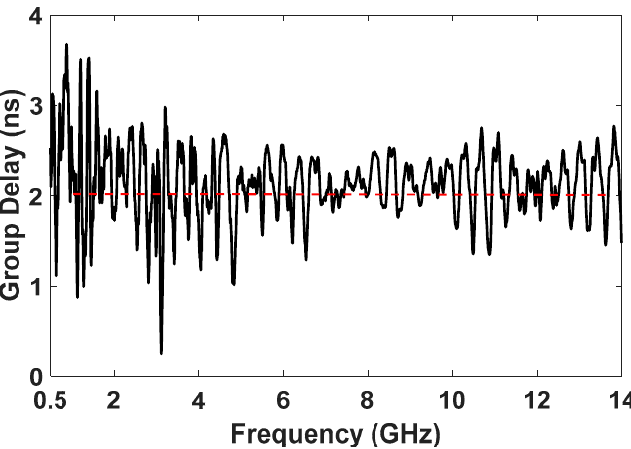
Figure 13. Measured group delay of the proposed antenna.